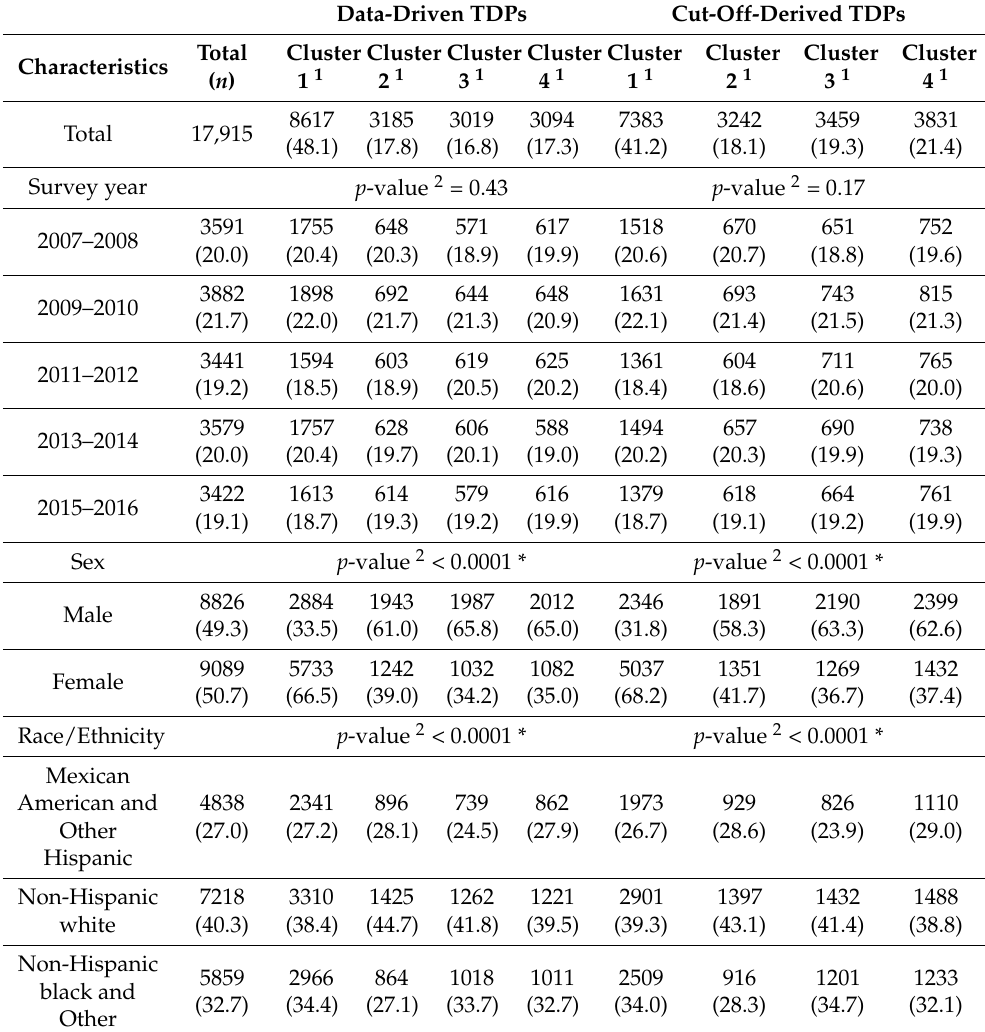
Table 2. Characteristics of clusters representing data-driven TDPs and cut-off-derived TDPs of U.S. adults 20–65 year as drawn from the NHANES, 2007–2016. Data-Driven TDPs Cut-Off-Derived